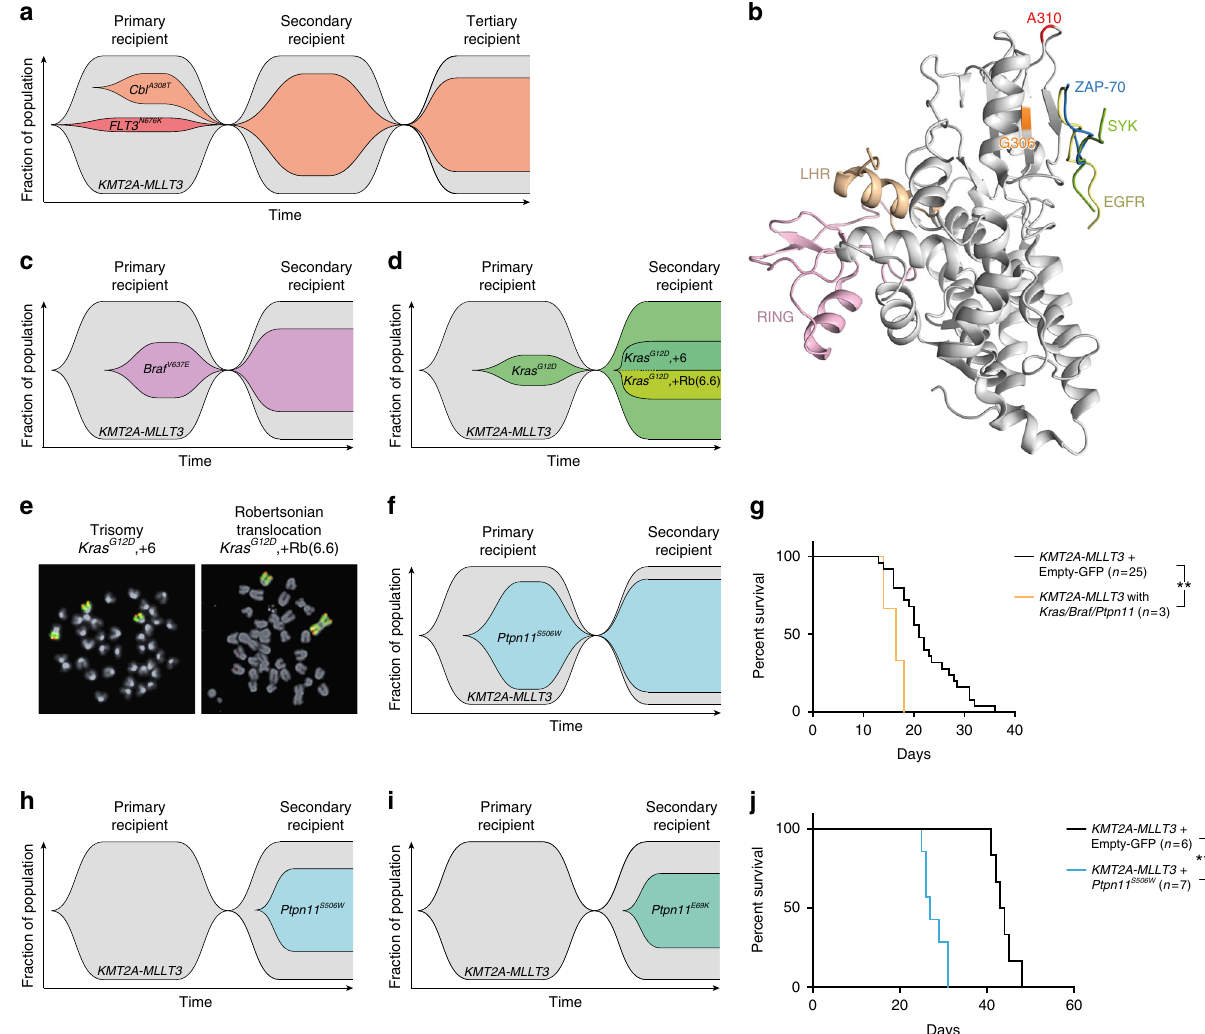
Fig. 3 KMT2A-MLLT3 cells acquire de novo signaling mutations. a Fish plot showing progression of one leukemia with a subclonal KMT2A-MLLT3 + FLT3 N676K (10.1%) that gained a Cbl A308T de novo mutation in the primary (SJ016337) KMT2A-MLLT3 -only cells which expanded and gained clonal dominance a secondary (SJ046291), and tertiary recipient; MAF 0.11->0.37->0.34. b Ribbon representation of the human N-terminal SH2-containing tyrosine kinase-binding (TKB) domain of CBL (gray), overlayed with ZAP-70 (blue), SYK (green) and EGFR (yellow) peptides, and including the RING domain (pink), LHR (beige), and with residue G306 (orange) and A310 (red) highlighted. c , d Fish plots of primary KMT2A-MLLT3 + Empty-GFP recipients that gained de novo mutations and their subsequent progression in secondary recipients showing c a primary subclonal Braf V637E that increased in size; MAF 0.20 (SJ018146) ->0.30 (SJ046293), d a subclonal Kras G12D that progressed to clonal dominance; MAF 0.11 (SJ016338) ->0.59 (SJ046295). The MAF of 0.59 indicated allelic imbalance and was caused by a gain of chromosome 6 ( + 6) and a Robertsonian translocation ( + Rb(6.6)), each present in 20% of cells, as shown by fl uorescence in situ hybridization (FISH). e FISH results of the Kras locus (red) in d , showing gain of chromosome 6 (green) by trisomy in 8/38 (21%) metaphases and by a Robertsonian translocation involving two copies of chromosome 6 (Rb(6.6)) in addition to a normal chromosome 6 in 8/38 (21%) metaphases. Together with the observed MAF this suggests that all disomic cells were heterozygous for Kras G12D mutation and all cells with three copies of chromosomes 6 had duplicated the mutated allele. f Fish plot showing a dominant Ptpn11 S506W which was preserved in size; MAF 0.39 (SJ016332) ->0.41 (SJ046294). g Kaplan – Meier survival curve for secondary KMT2A-MLLT3 recipients, showing accelerated disease for mice that harbored Braf V637E , Kras G12D , and Ptpn11 S506W ( n = 3) as compared to those lacking an identi fi ed de novo mutation ( n = 25; P = 0.0083. Mantel – Cox log-rank test). h , i Fish plots of secondary KMT2A-MLLT3 + Empty-GFP recipients that gained de novo mutations in h Ptpn11 S506W and i Ptpn11 E69K (MAF 0.31 and 0.29, respectively). j Kaplan – Meier curves of mice transplanted with BM co-transduced with either KMT2A-MLLT3 + Ptpn11